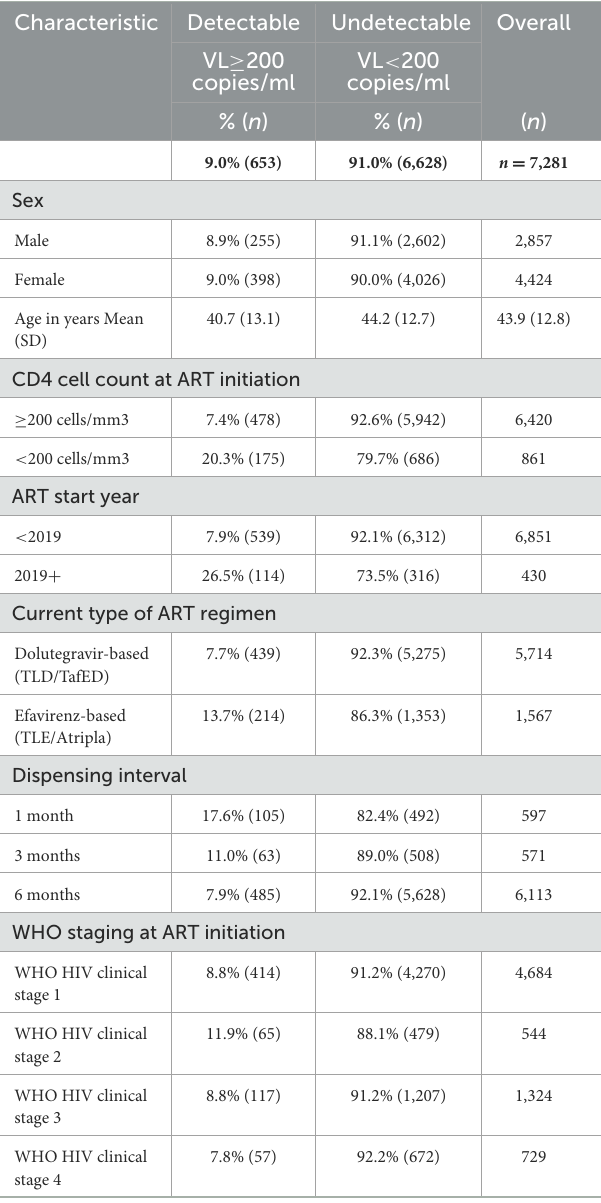
TABLE 1 Demographic and clinical characteristics of adult PLWHIV by viral detectability at AIDC of UTH, Lusaka, Zambia ( n = 7,281).